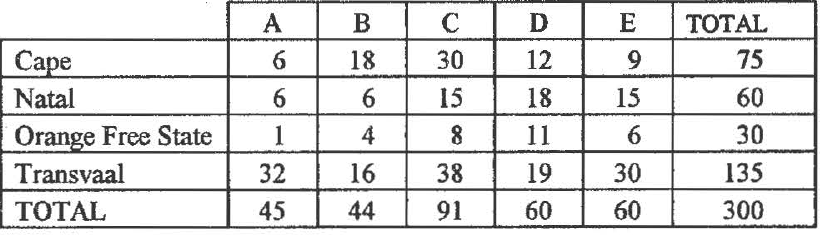
Table 2 :Allocation of seats to